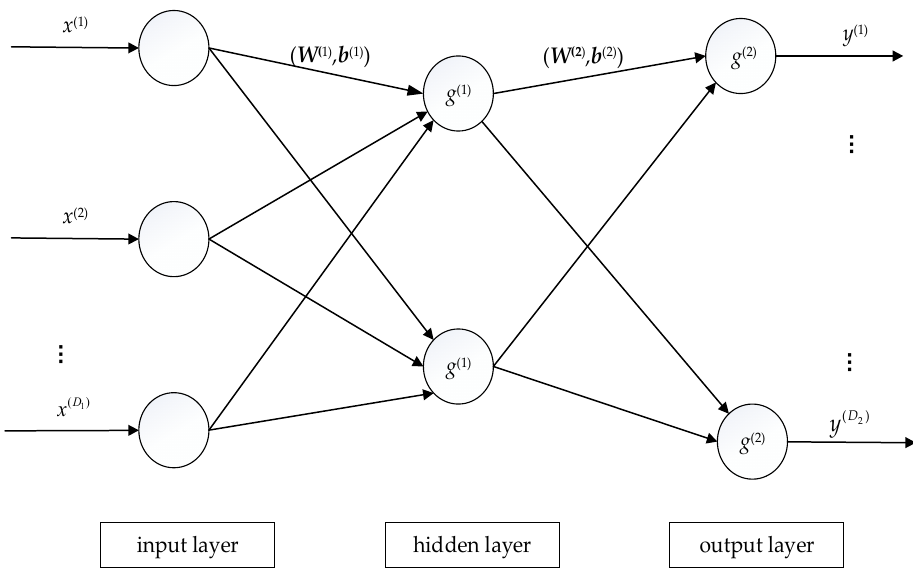
Figure 5. Diagram of a BP neural network with a single hidden layer.